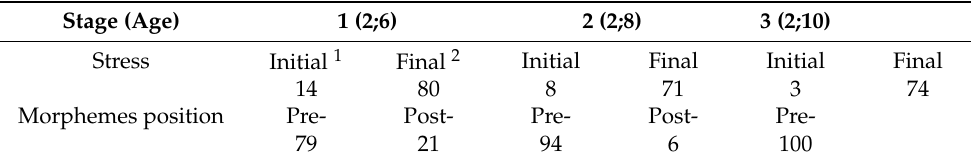
Table 2. Proportion of initial and final stress pattern (% of the total number of patterns) and of pre- and postposed morphemes in the Swedish utterances of Ann (French